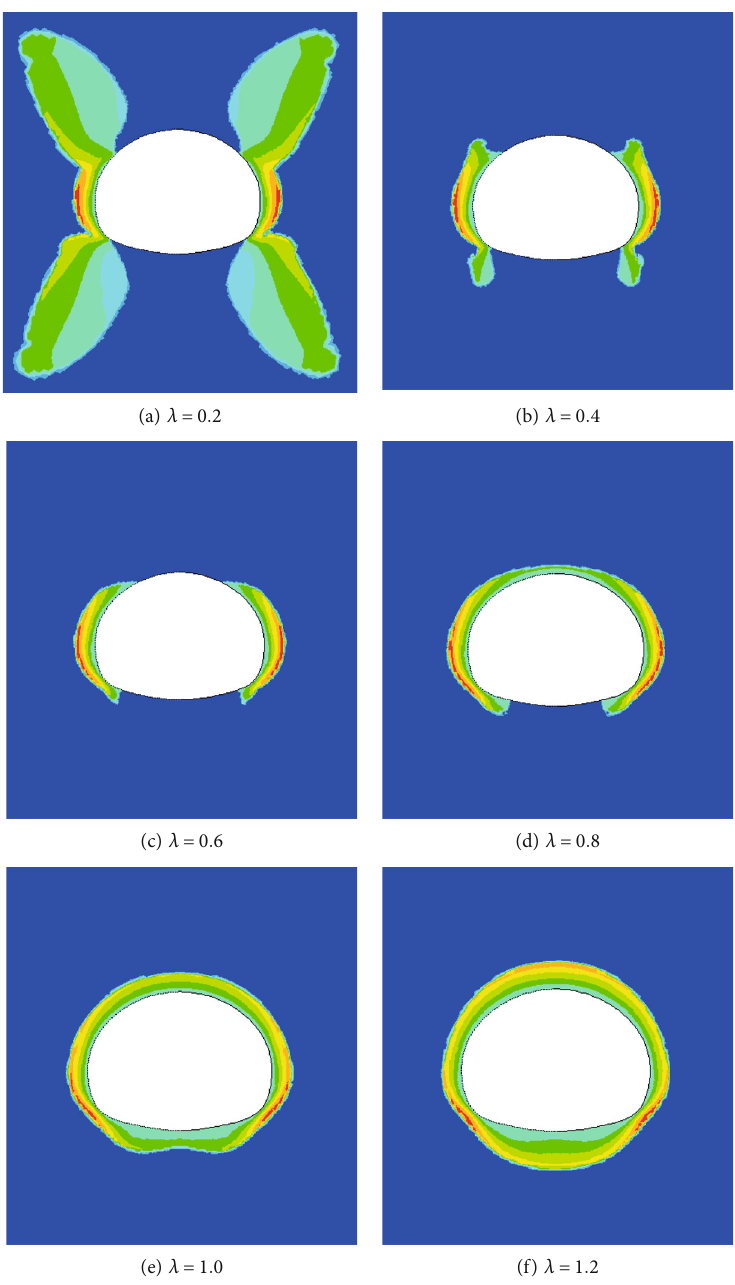
Figure 8: The plastic zone for di ff erent λ predicted by